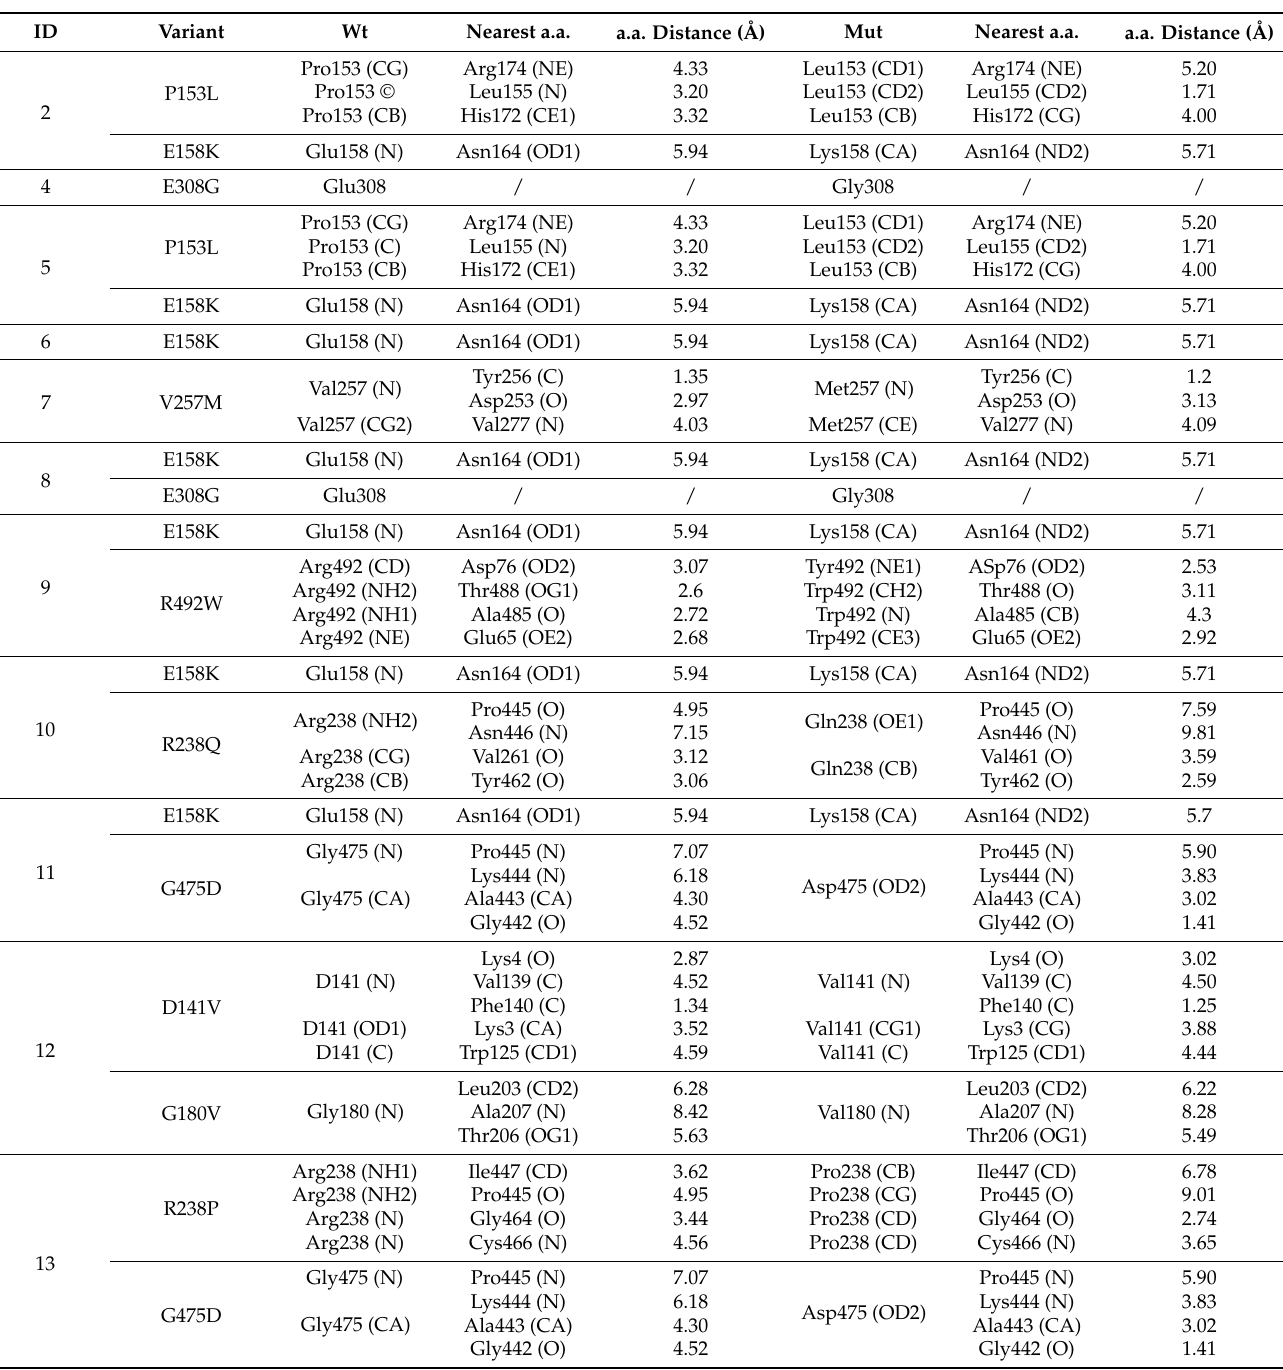
Table 3. FMO3 missense variants highlighting the highest distance differences between changed amino acid and nearest ones. The wild-type alleles compared to mutated ones showed possible interactions with difference nearest amino acids, also involving different atoms or functional groups (between brackets). Side chains functional groups are reported following the IUPAC-IUB Commission on Biochemical Nomenclature. Wt = wild-type amino acid and atom/functional group involved in a possible interaction with the nearest aa. Mut = mutated amino acid and atom/functional group involved in a possible interaction with the nearest